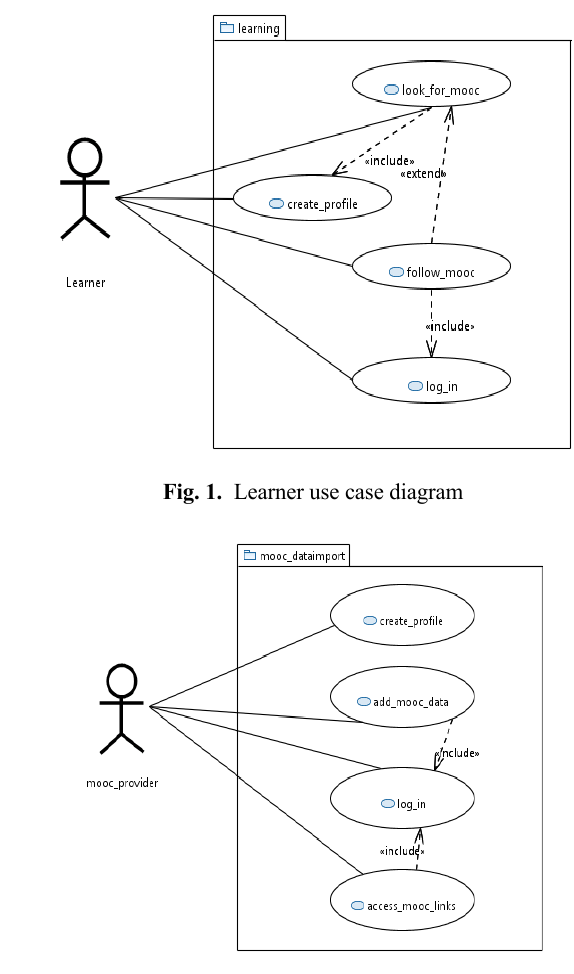
Fig. 2. MOOC use case